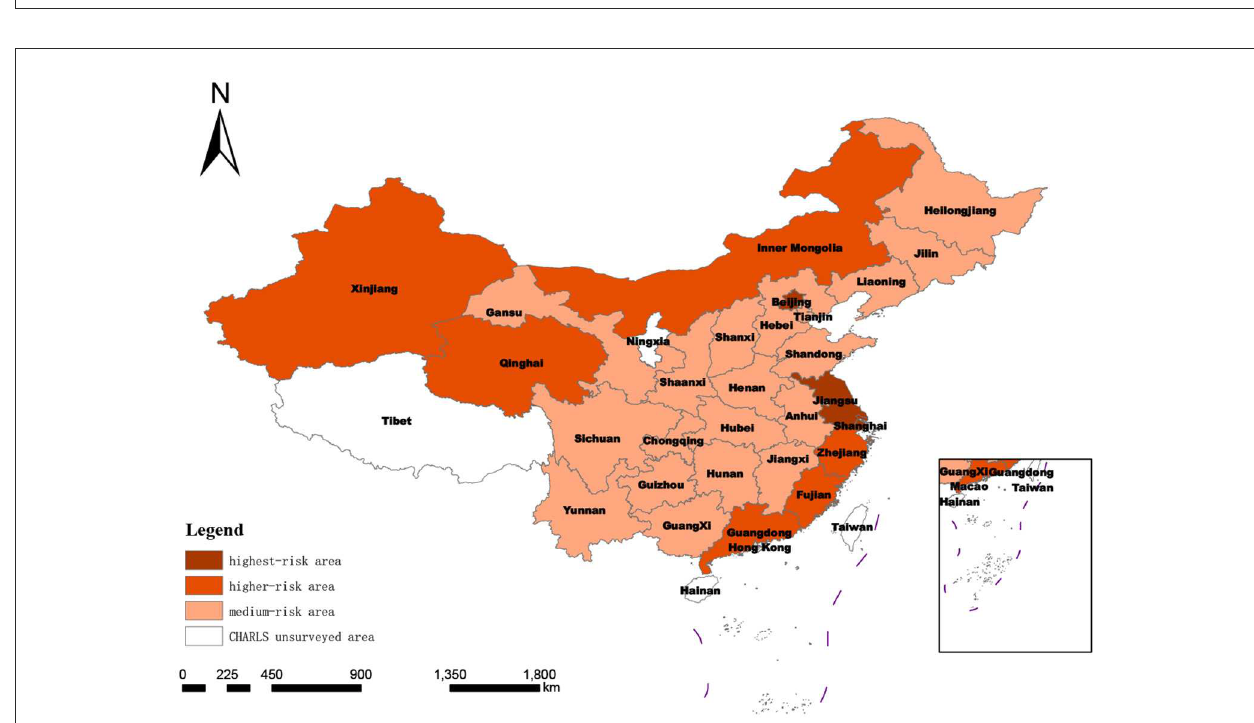
FIGURE5 Spatial distribution of degree of regional social disability risk under mesosystem score.